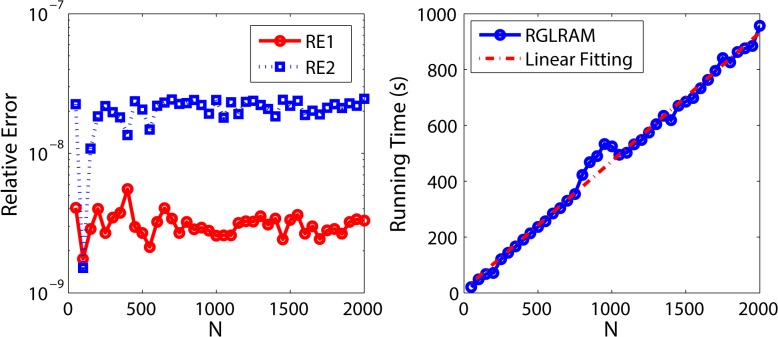
Experimental results of RGLRAM with different N.The left represents the relative errors with different N and the right represents the running time with different N.